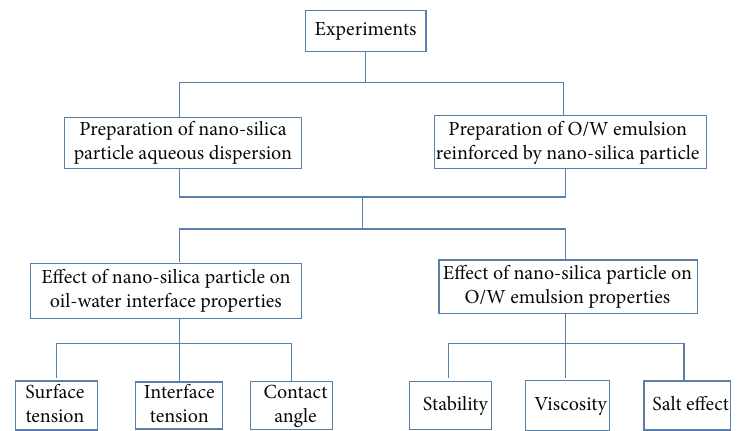
Figure 2: The fl owchart of the